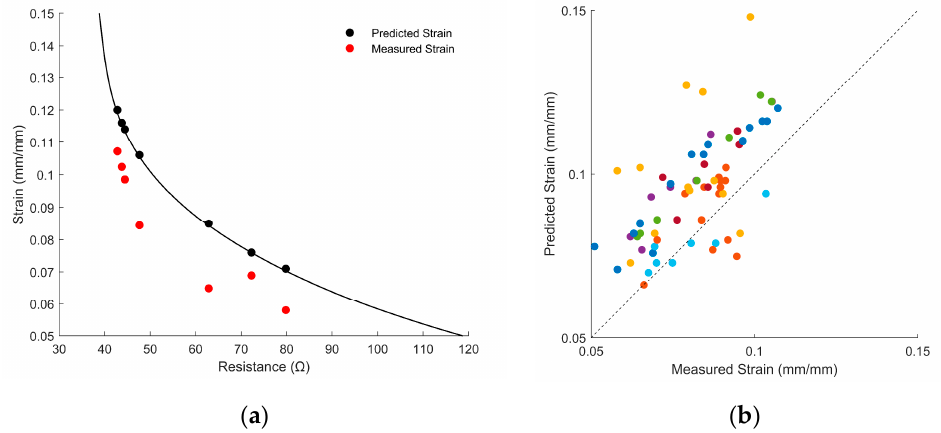
Figure 8. ( a ) The quasi-static strain model (black line), the model prediction at the randomly selected strain points (black dots), and the actual strains (red dots) for a single sensor. Vertical distances between black and red line represent the model error. ( b ) Scatterplot of the randomized strains (x-axis) compared to the model prediction (y-axis) for all 10 sensors (each strain gauge is indicated by a different color). Predictions that fall on the dotted black line are exactly accurate.